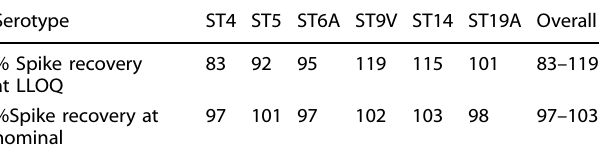
Table 4. Accuracy assessed by sipke recovery.